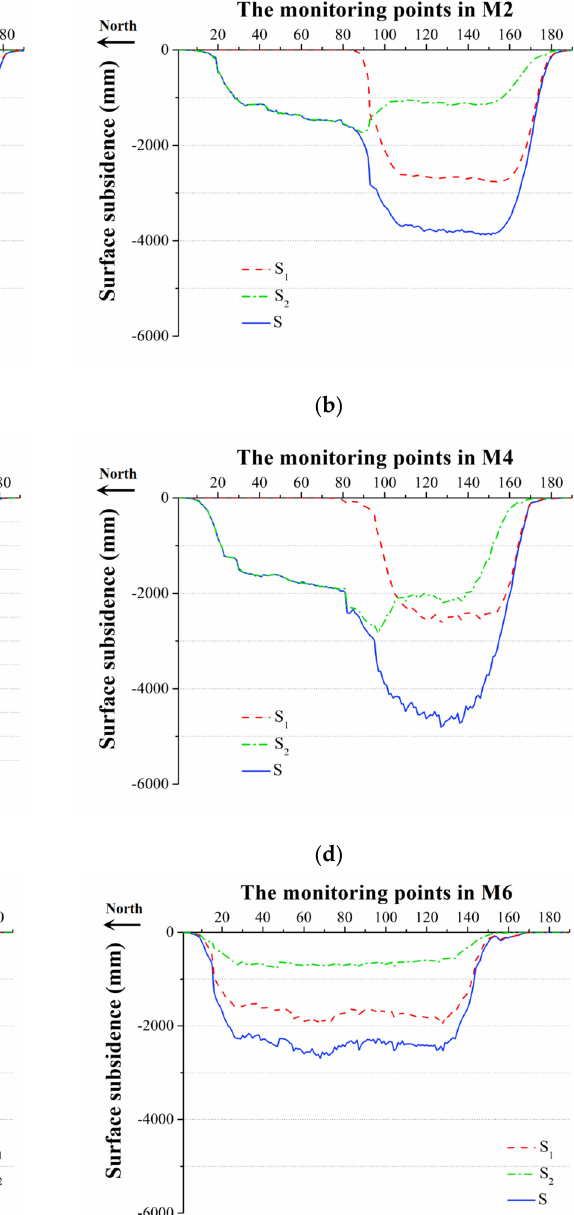
Figure 12. The transverse section of the S 2 contour (section I ‐ I is shown in Figure 9).